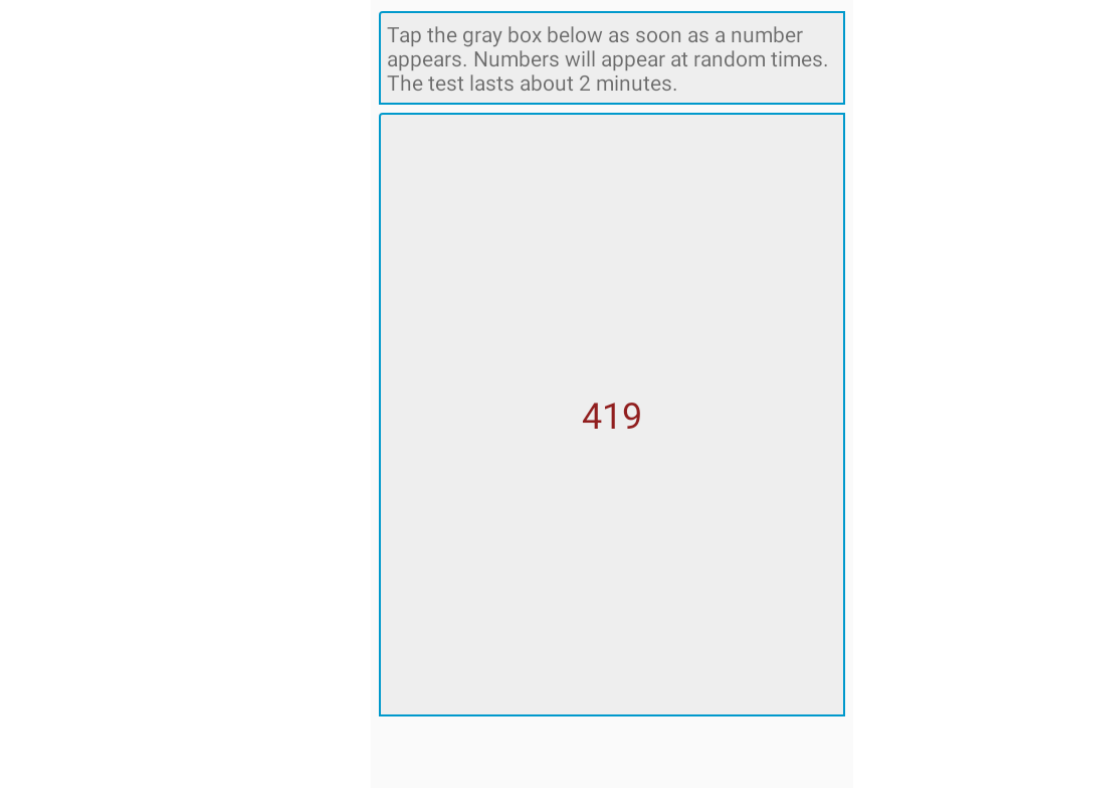
Figure 3. Screenshot of the ADD